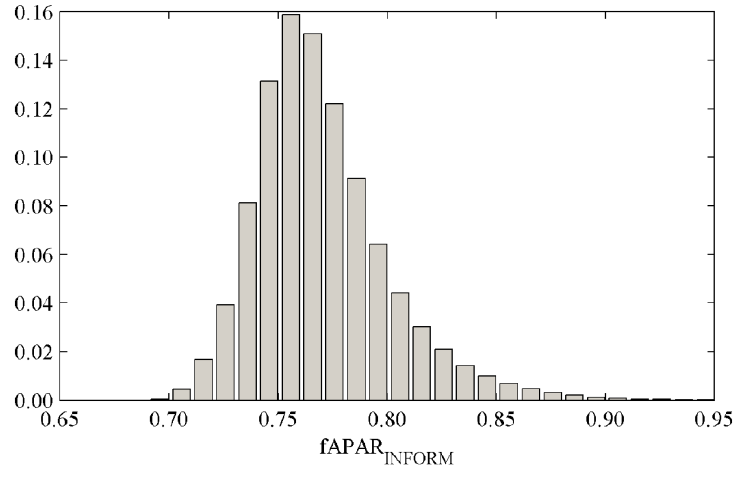
Figure 13. Frequency distribution of the forest fAPAR map of the study area. Only pixels covered with forest are taken into account. No pixel is excluded for terrain